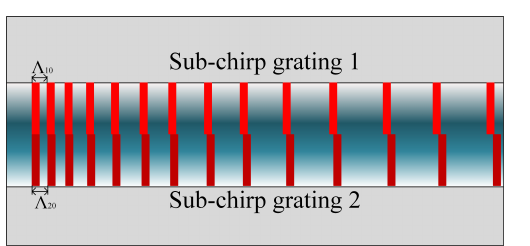
Figure 1. Schematic diagram of the longitudinal section of the 2D chirped fiber grating. Two subchirped gratings are written at the same position of the fiber core without any overlap. The effective refractive index of the optical fiber core is n ef f , the initial periods of the two subgratings are Λ 10 and Λ 20 , the chirp rate is C , and the refractive index modulation amplitude is ∆ n 0 . With these variables defined, the refractive index distribution in the core of the 2D chirped fiber grating can be calculated with Equation (1), as